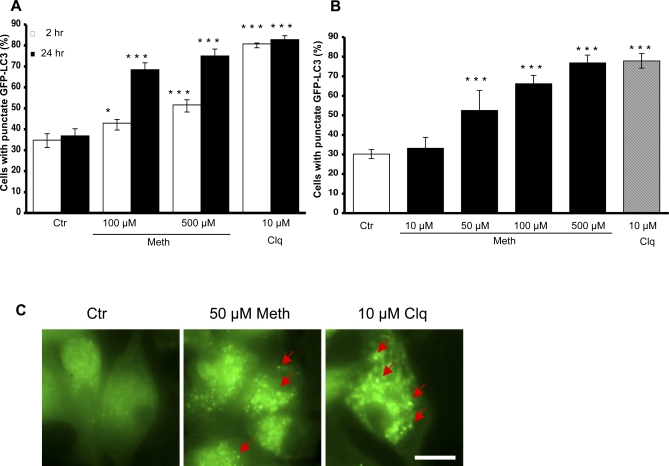
Meth Induces Autophagosome Accumulation in Dendritic Cells(A) Accumulation of GFP-LC3 labeled autophagosomes in Meth- or Clq-treated dendritic cells at 2 h and 24 h. Fisher's exact test P values versus control (n =300–400 cells, mean ± SEM, *p < 0.05, ***p < 0.0001).(B) GFP-LC3 labeled autophagosome formation in different concentrations of Meth after 24 h treatment. Similar results were obtained in three independent experiments. Fisher's exact test versus control (n = 300–400 cells, mean ± SEM, ***p < 0.0001).(C) Representative fluorescence micrographs of GFP-LC3 decorated autophagosomes in cells treated with 50 μM Meth or 10 μM Clq for 24 h. Arrow denotes examples of autophagosomes. Scale bar, 10 μm.